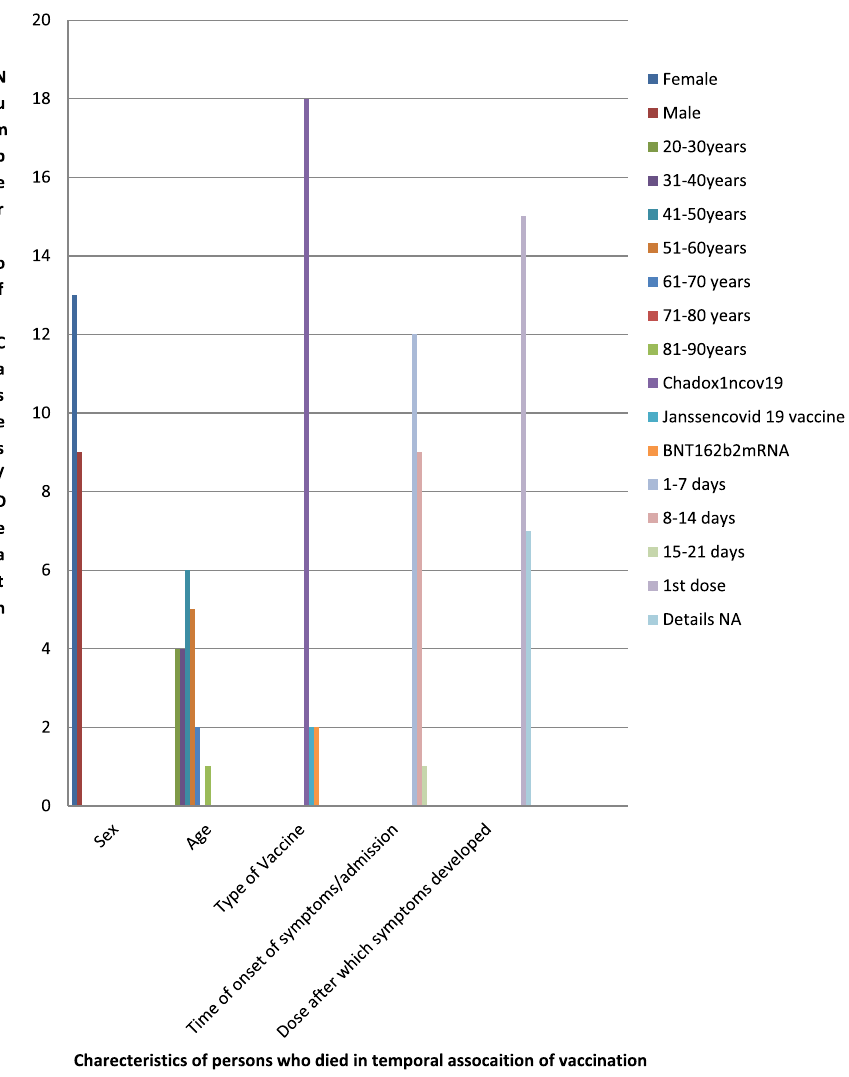
Fig. 1 Characteristics of persons who died in the temporal association of vaccination along with number of